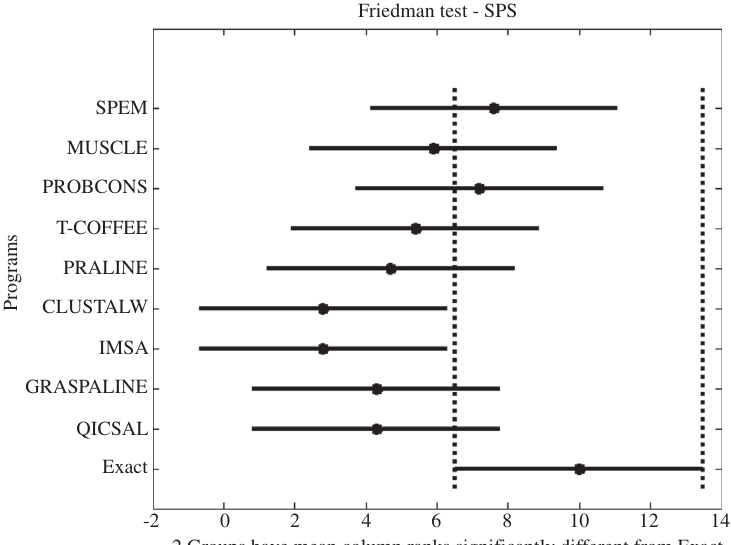
Figure 12. Friedman Test for SPS.